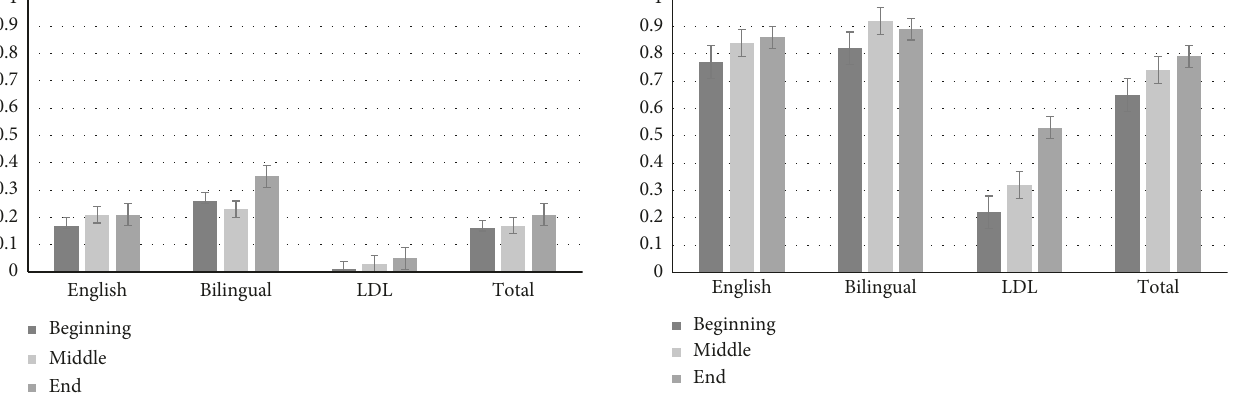
Figure 1: Means and standard errors for WER I (perfect T-unit: no grammatical errors) at the beginning, middle, and end of the year by language groups.